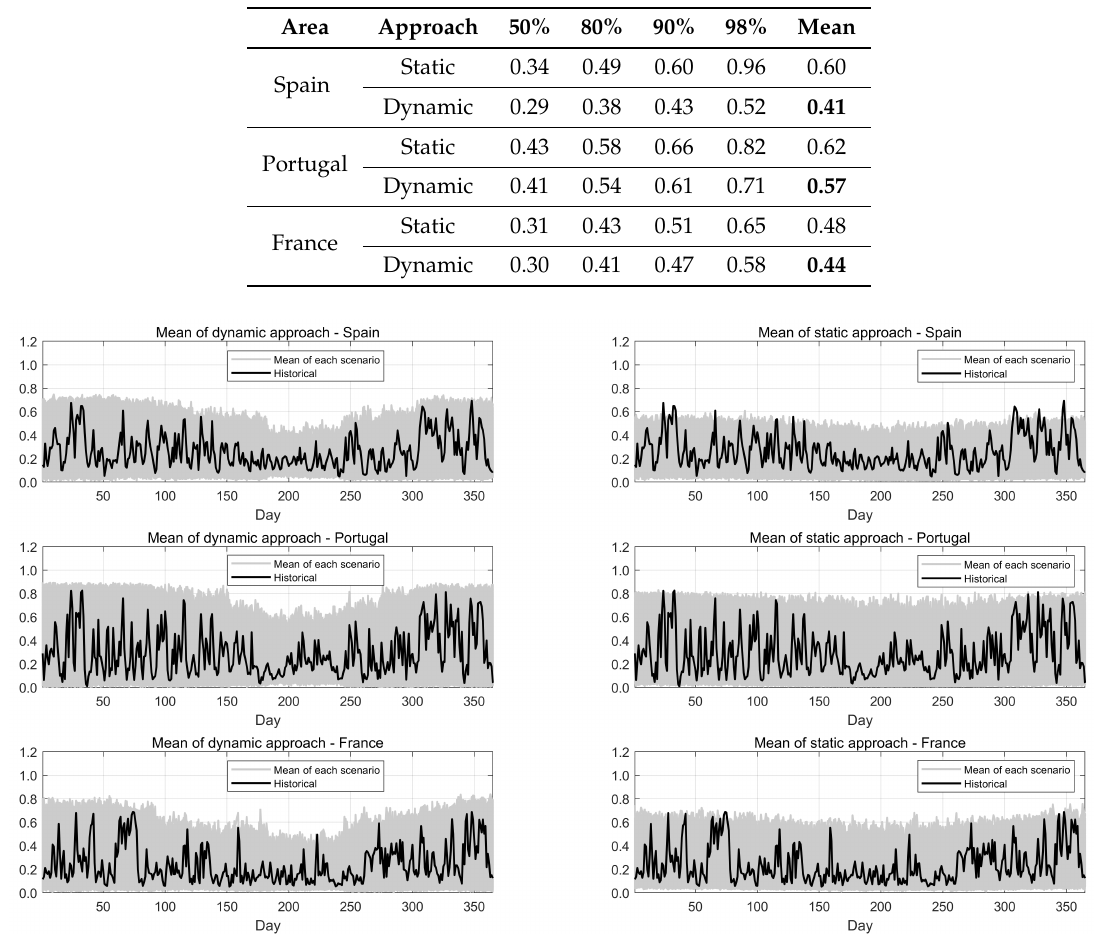
Figure 10. Comparison for mean at a daily